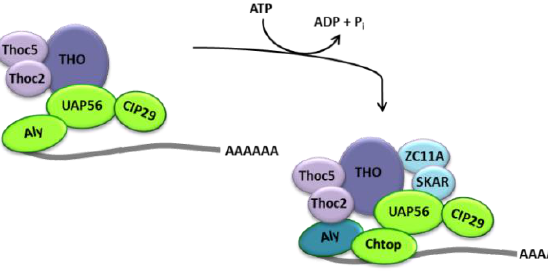
Figure 2. UAP56 assembles the TREX complex in an ATP-dependent